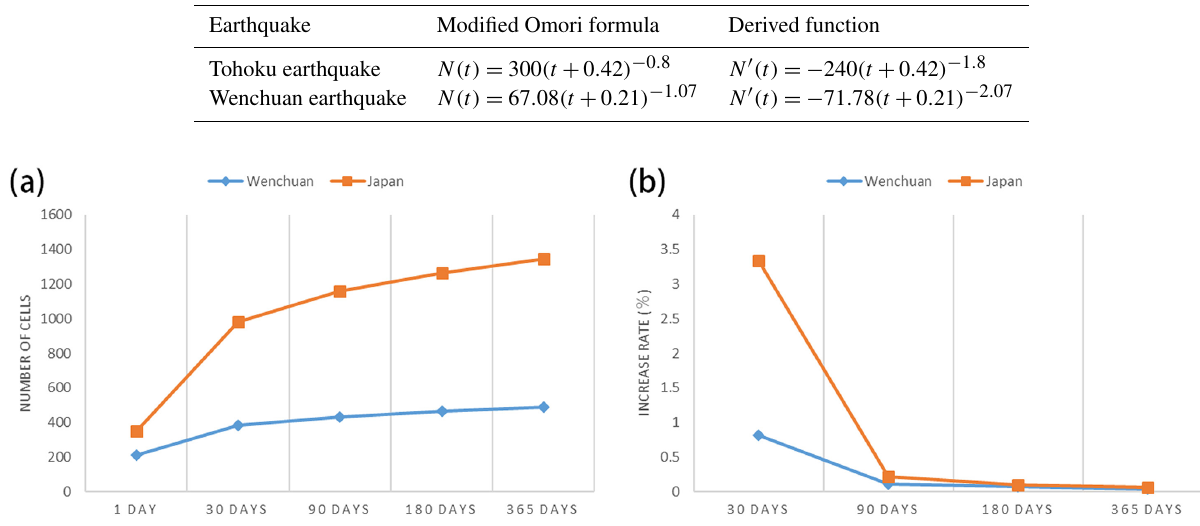
Figure 15. The curve of the aftershock hysteresis effect (actual aftershocks). Panel (a) shows the change in the number of cells with af- tershocks at different timescales, and panel (b) shows the change in the growth rate of the number of cells with aftershocks at different